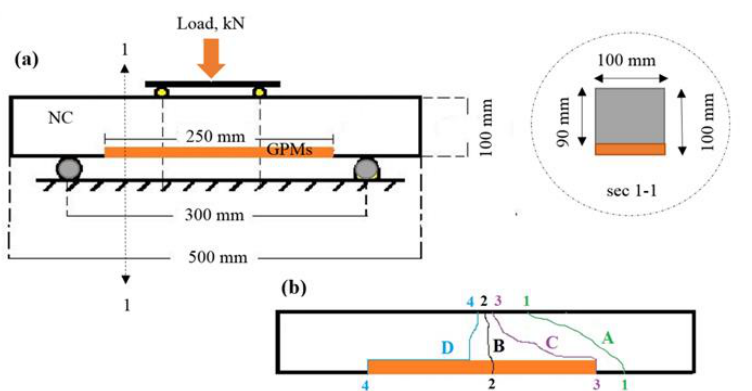
Figure 18. Compatibility between concrete substrate and GPMs.